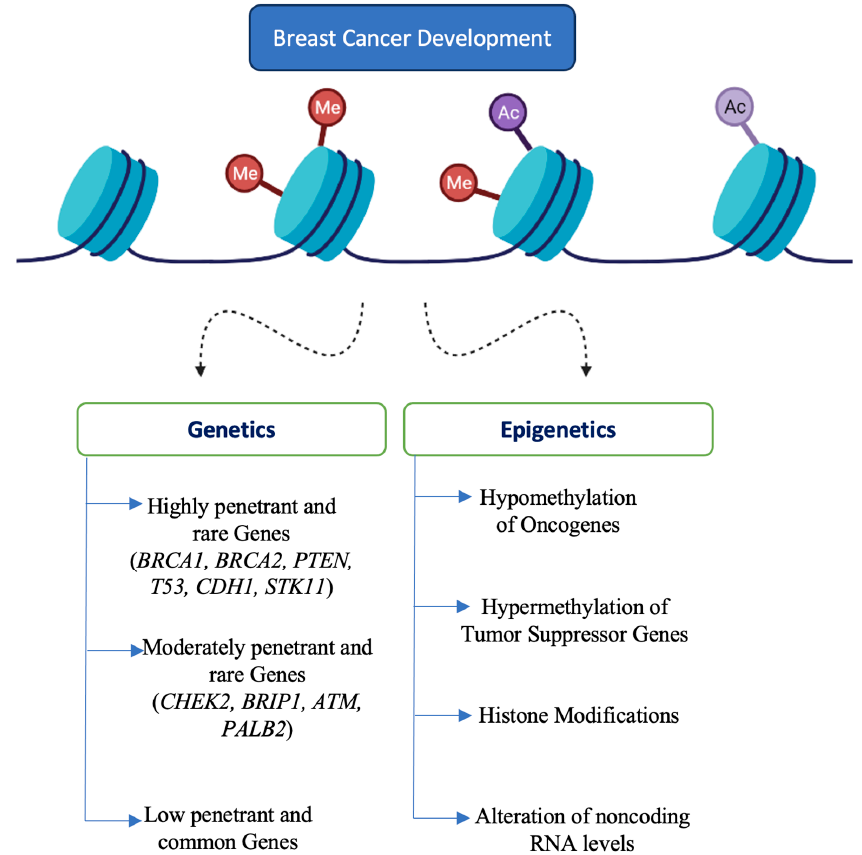
Figure 2. Genetic and epigenetic contributors of breast cancer. Legend: breast cancer gene A ( BRCA ), phosphatase and tensin homolog ( PTEN ), tumor protein p53 ( TP53 ), cadherin-1 ( CDH1 ) and serine/threonine kinase-11 ( STK11 ), checkpoint kinase 2 ( CHEK2 ), BRCA1-interacting protein-1 ( BRIP1 ), ataxia telangiectasia mutated ( ATM ), partner and localizer of BRCA2 ( PALB2